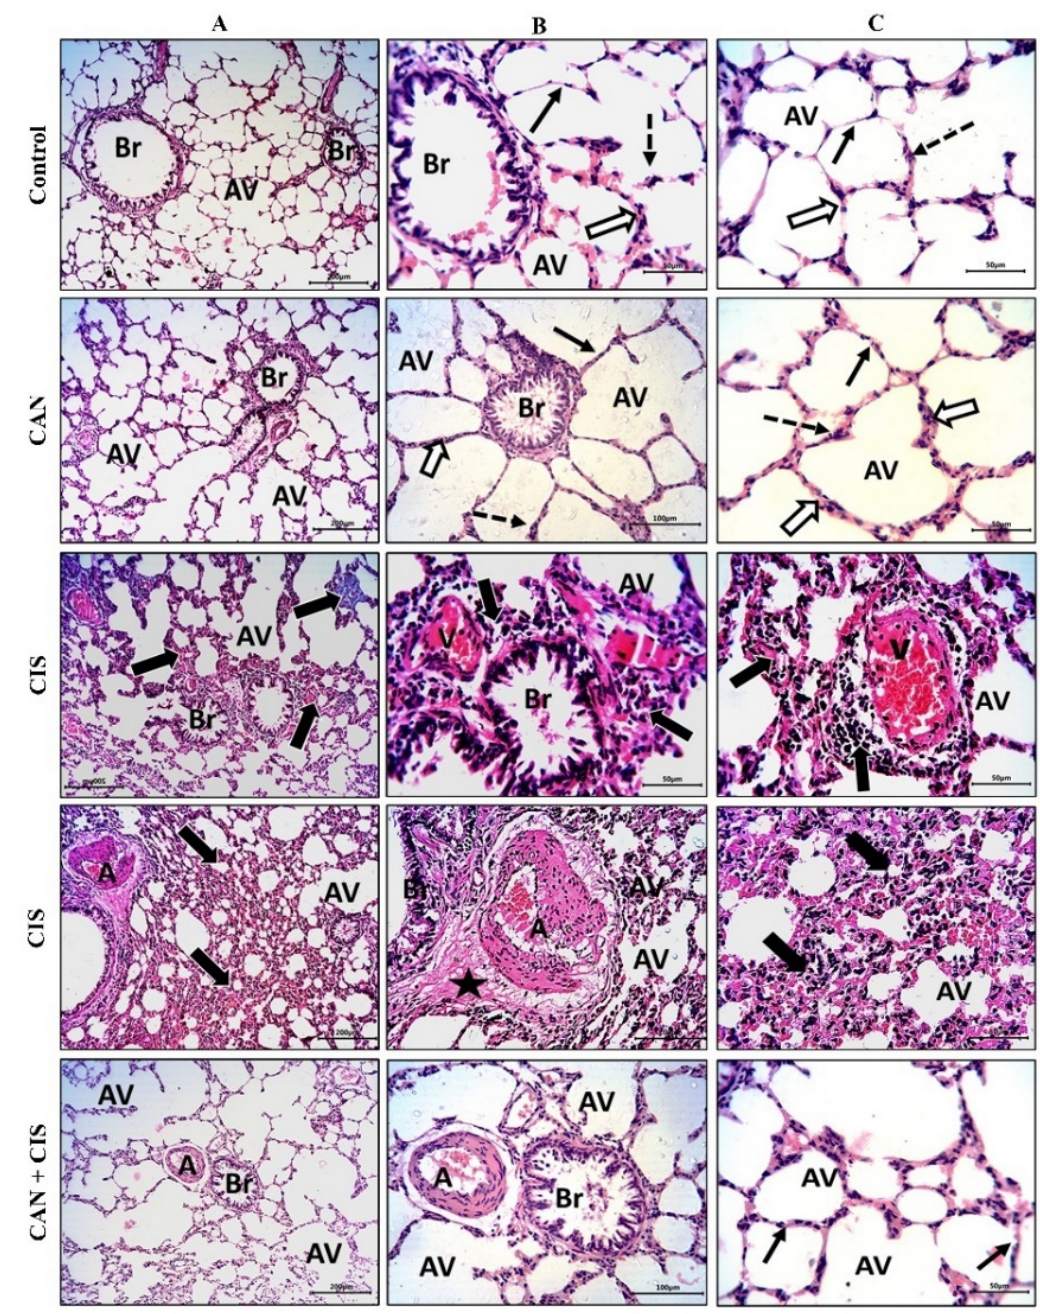
Figure 1. CAN prevented CIS-induced lung tissue injury. Photomicrographs of H&E-stained sections showing alveoli (AV) and bronchioles (Br) at × 100 ( A ), and at × 200 magnification ( B , C ). Control and CAN-treated rats showed normal alveoli lined with a thin type I alveolar epithelium (black arrows) with occasionally prominent rounded nuclei of type II cells (dotted arrows), thin interalveolar septa with no inflammatory cells (white arrows), and bronchioles (Br) with intact epithelium and lumen free of cell debris or secretions (Figure 1A–C). CIS-administered rats exhibited a decrease in the number of potent alveoli (Av), thick interalveolar septa with inflammatory cells (thick black arrows), congested veins (V) with perivascular mononuclear infiltrate (thick black arrows), thickened and deformed arteries (A), and perivascular edema (star). CAN-treated CIS-administered rats showed a significant improvement in the alveoli (AV), bronchioles (Br), and interalveolar septa (thin black